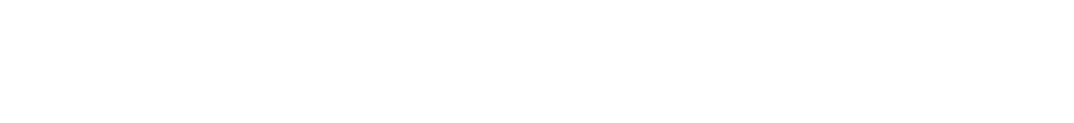
Frontiers in Psychology | Auditory Cognitive